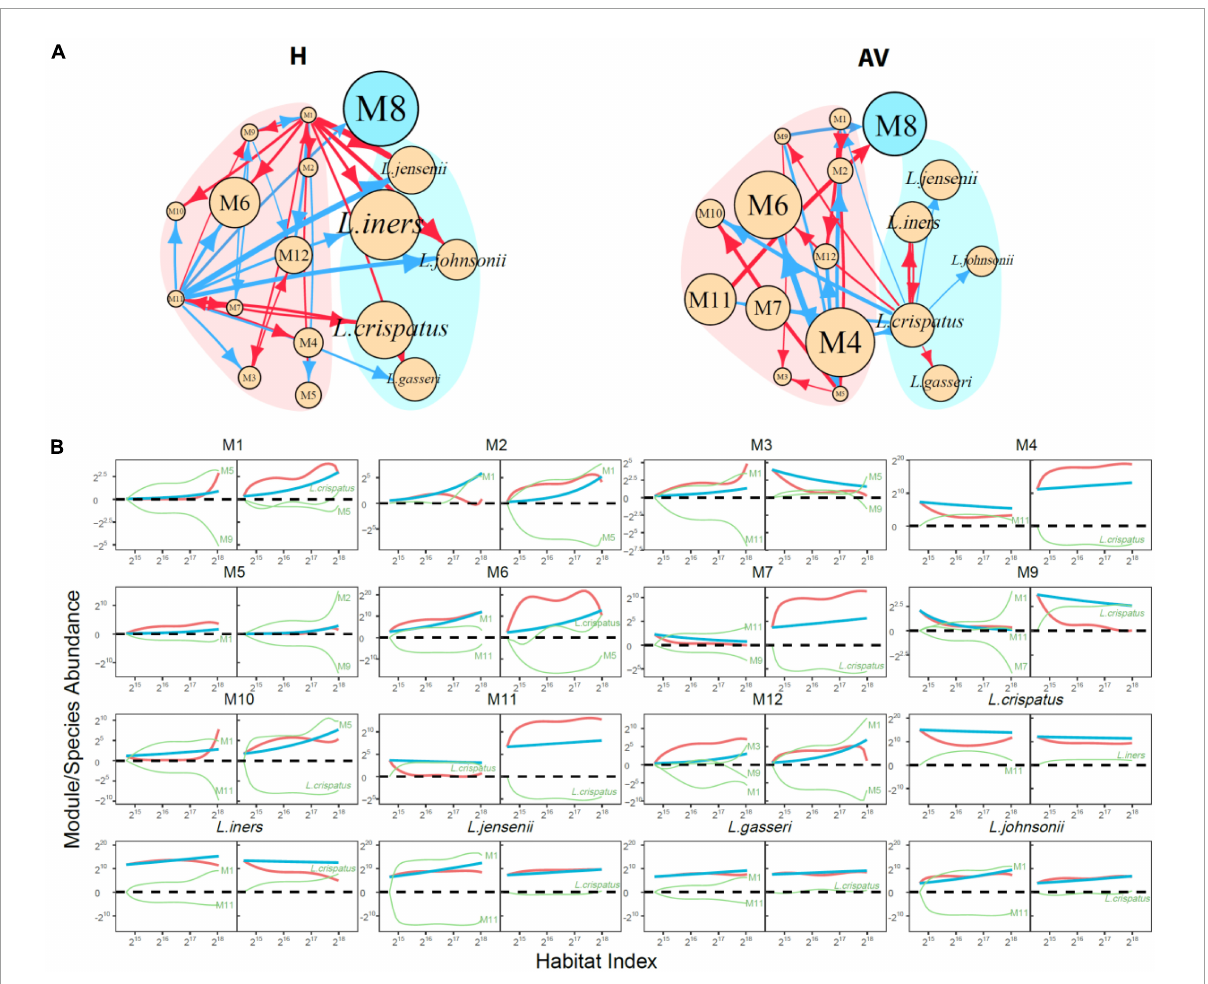
FIGURE5 Functional idopNetworks among modules. (A) Network architecture showing the difference between healthy (H) and AV groups. Genus Lactobacillus is the only module contained in module M8, whose five most abundant species are added into the network. Red and blue lines denote promotion and inhibition, respectively, with line thickness proportional to the strength of interactions. (B) Decomposition of the net abundance trajectory (blue line) of each module into its independent abundance trajectory (red line) and dependent abundance trajectory (green line) in the H group (left panel) and AV group (right panel). The names of modules that regulate a given module are shown in the plot (positive regulators above the zero line and negative regulators above the zero